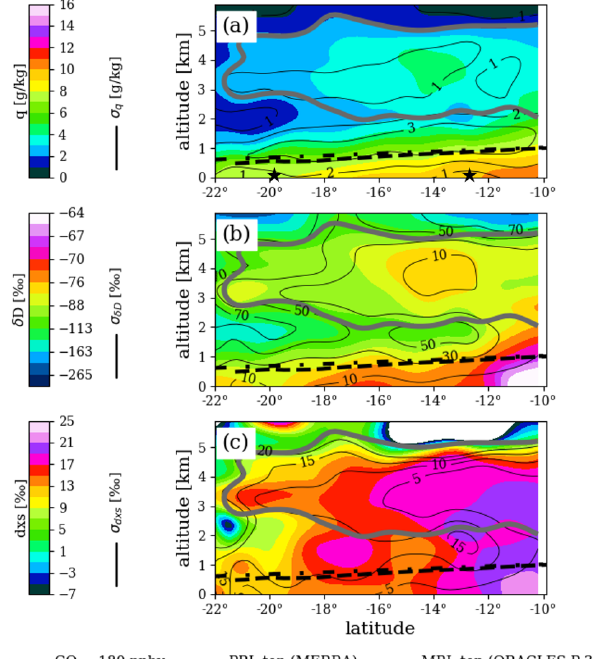
Figure 6. Latitude–altitude curtains of WISPER mean q (a) , q - weighted δ D (b) , and q -weighted dxs (c) for the ORACLES 2016 sampling period. Curtains were generated using a Gaussian kernel estimation method after averaging the 1Hz data into 30s blocks and removing any data where q < 0 . 2gkg − 1 . Thin black contours denote standard deviations. Thick gray contour shows 180ppbv in situ carbon monoxide measured by the COMA system; it bounds the 2–5km region where biomass burning air was often present. Black dashed line shows planetary boundary layer top taken from MERRA monthly mean output for September 2016. Black dash- dotted line shows a linear regression of MBL capping inversion bot- tom vs. latitude using P-3 in situ measurements. Inversion bottoms were estimated using vertical profiles of temperature and relative humidity. Black stars at the bottom of panel (a) are placed at the latitudes of the two vertical profiles in Fig.